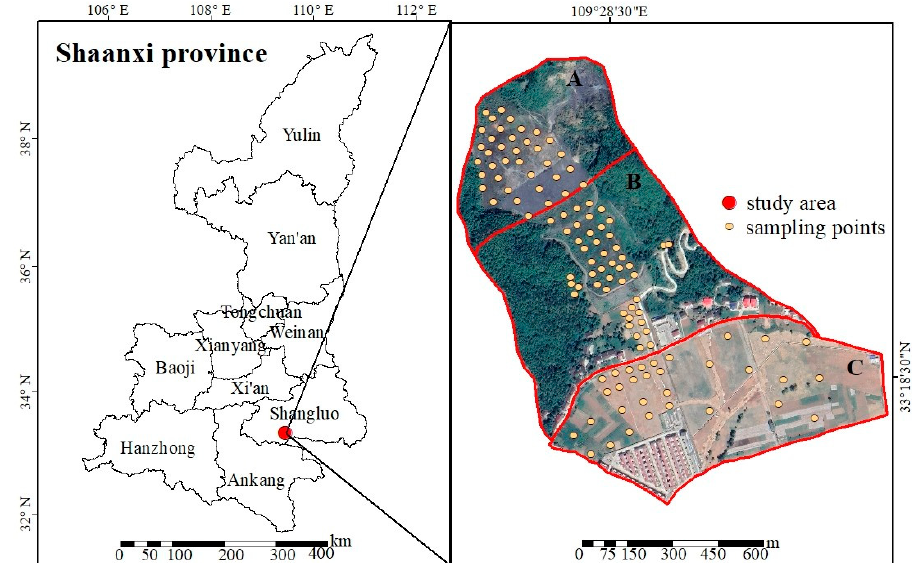
Figure 1. Location of the study area and sampling points (background image from Google Maps).